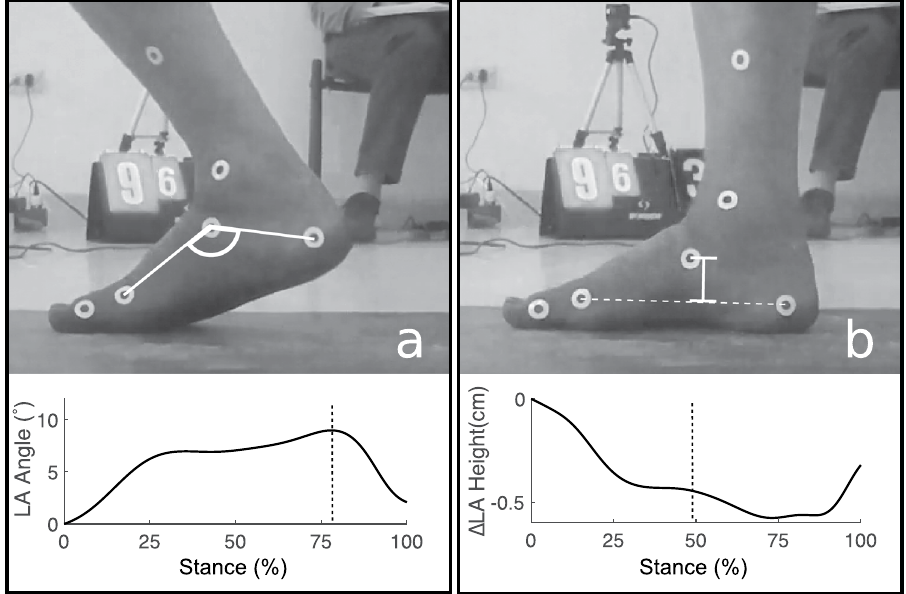
Figure 3. Measurements of LA kinematics during walking. ( a ) LA angle, where Max θ was measured at the maximum value across stance as indicated by the dashed line in lower graph. ( b ) Δ LA height, where Δ LA height was measured at mid-stance, as indicated by the dashed line in the lower graph. 0° and 0 cm height are defined by marker positions at foot